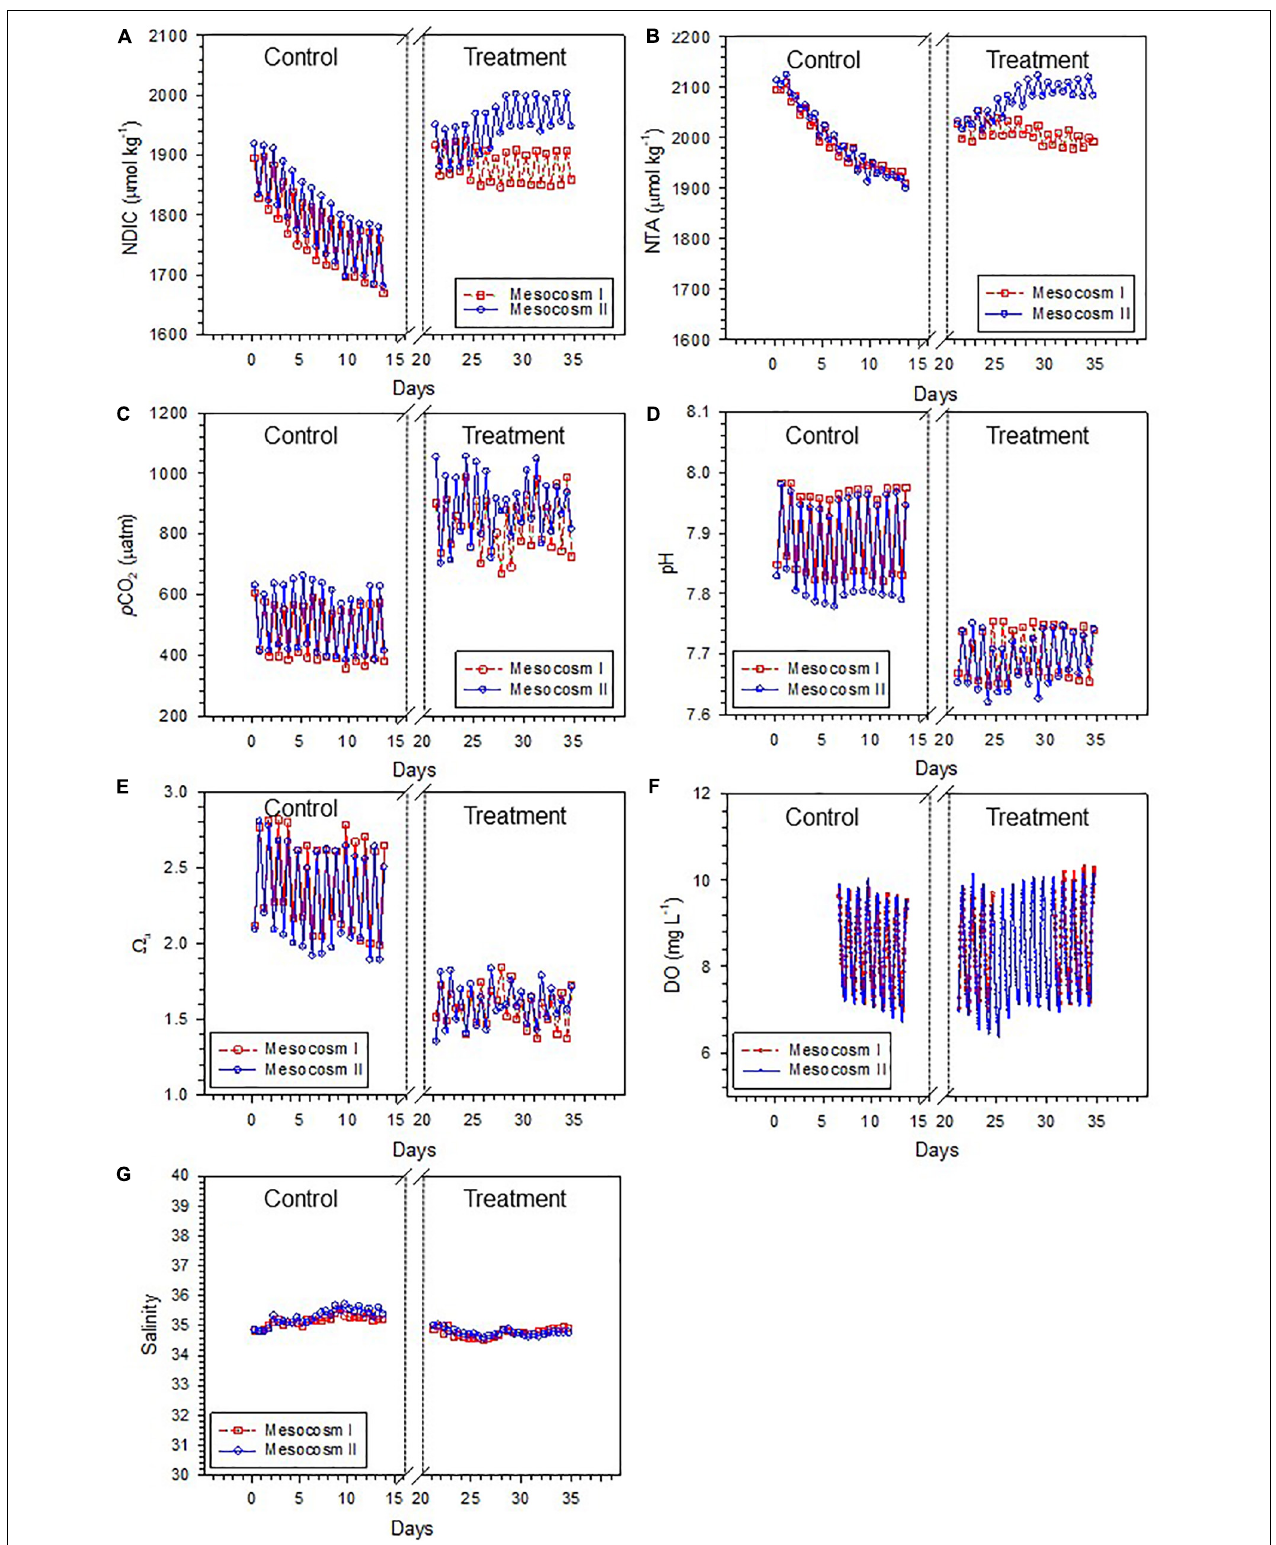
FIGURE 2 | Temporal variations of (A) salinity-normalized dissolved inorganic carbon (NDIC), (B) salinity-normalized total alkalinity (NTA), (C) partial pressure of CO 2 ( p CO 2 ), (D) pH, (E) aragonite saturation state ( (cid:127) a ), (F) dissolved oxygen (DO), and (G) salinity in mesocosms I and II during the control and treatment periods.